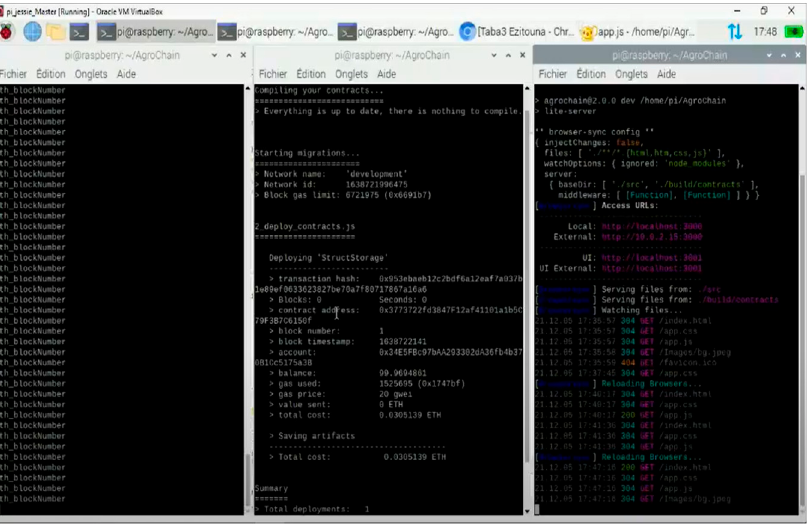
Figure 9. Blockchain implemented on Raspbian OS.